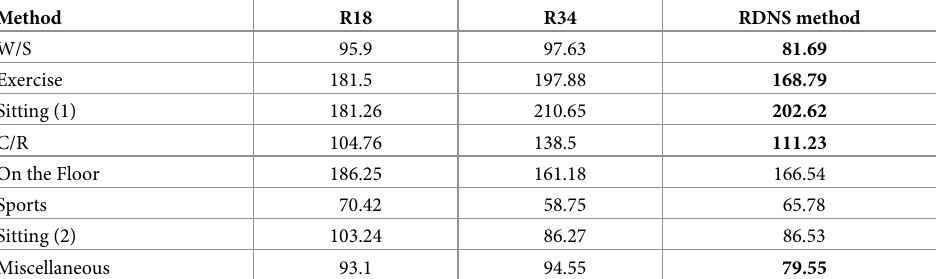
Table 7. The 3D estimation performance of our method in different actions. The data in the table is the mean error per joint position (MPJPE). The better results in our method are written in bold. R18 = Resnet-18, R34 = Resnet-34, W/S = Walking/Standing, C/R = Crouch/Reach. The unit of MPJPE is mm